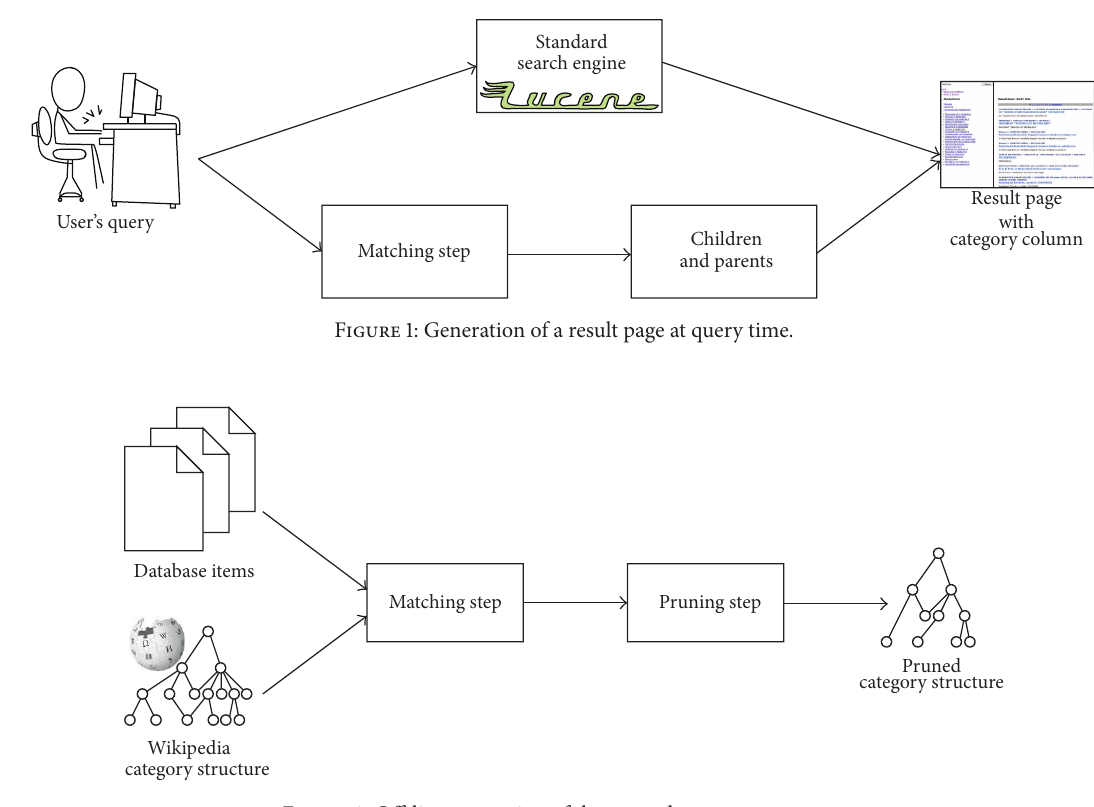
Figure 2: Off-line generation of the pruned category